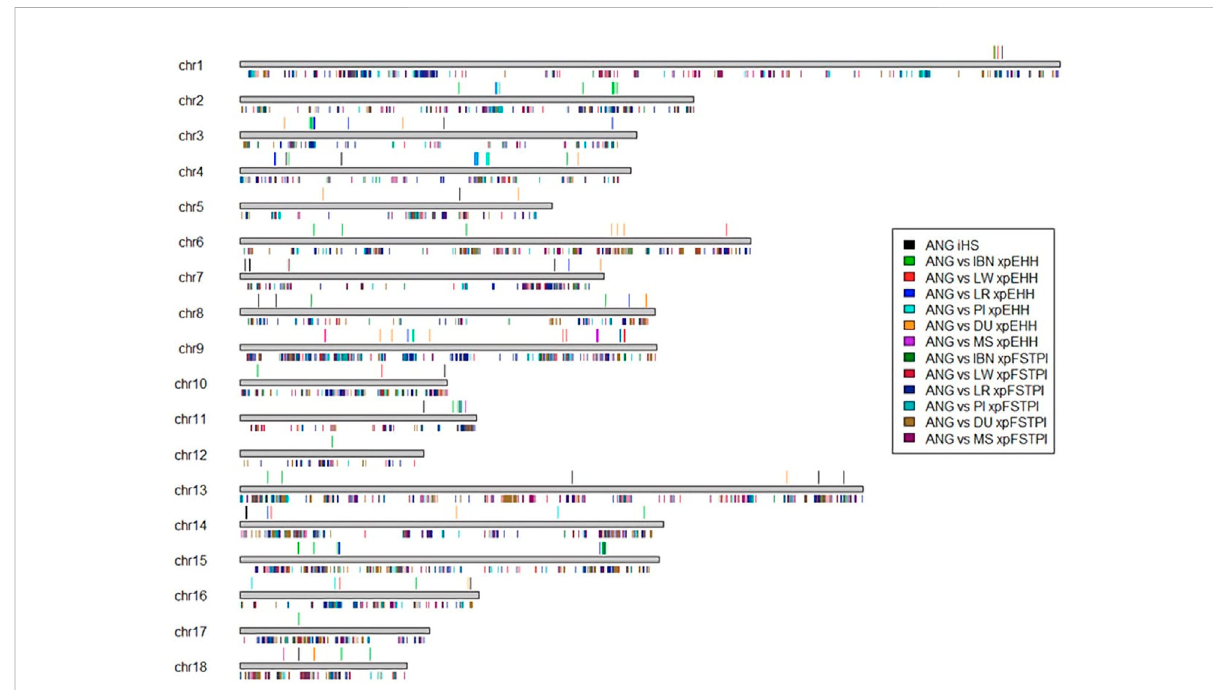
FIGURE 7 Summary representation of candidate sweepsfound usingthenucleotide diversity/ fi xation indexcross analysis(xpFST/ θπ )and haplotype scans (iHS and xpEHH). Three different statistics were used to identify regions under positive selection: iHS for within population and xpFST/ θπ and xpEHH for between-populations analysis. All candidate regions identi fi ed with these tests are summarized in this plot. Horizontal grey bold lines represent chromosomes. Colored vertical lines represent positions of candidate selective sweeps. Colored lines above chromosomes represent candidate regions identi fi ed using haplotype-based methods (iHS and xpEHH). Colored lines below chromosomes represent candidate regions